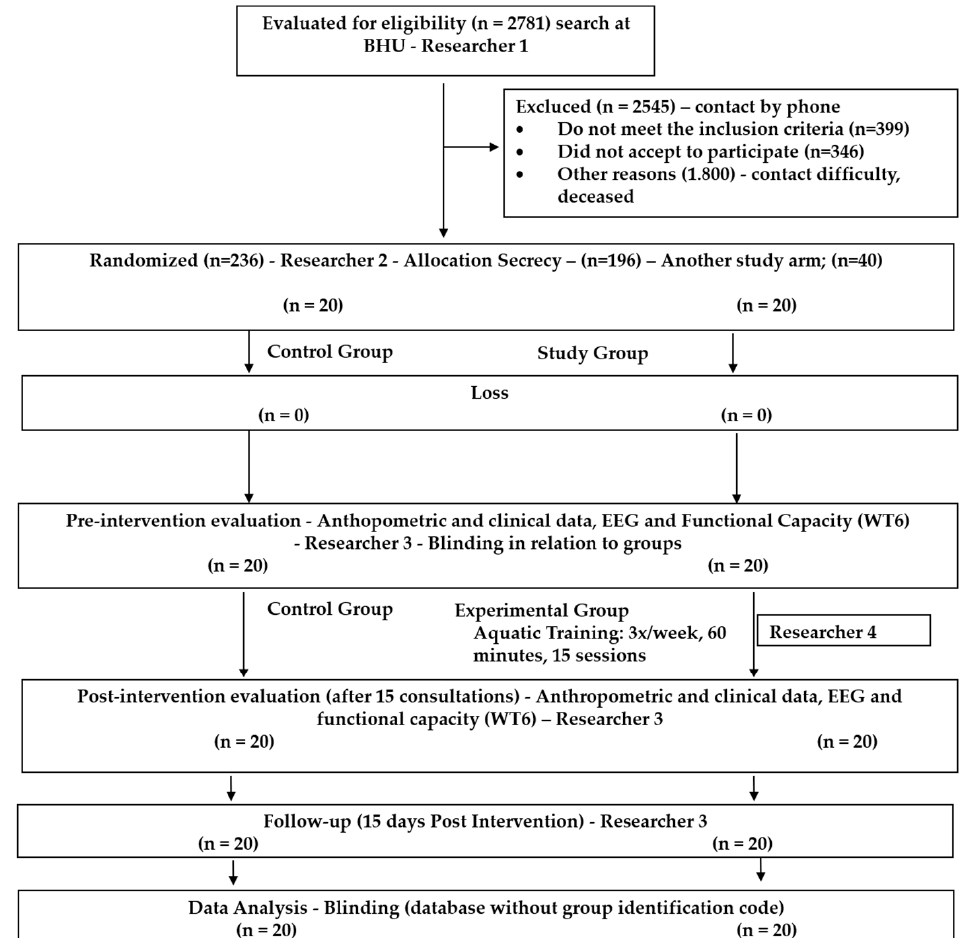
Figure 1. Design and flow chart of clinical trial participants. BHU: Basic Health Unit; EEG: electro- encephalogram; WT6: six-minute walk test.